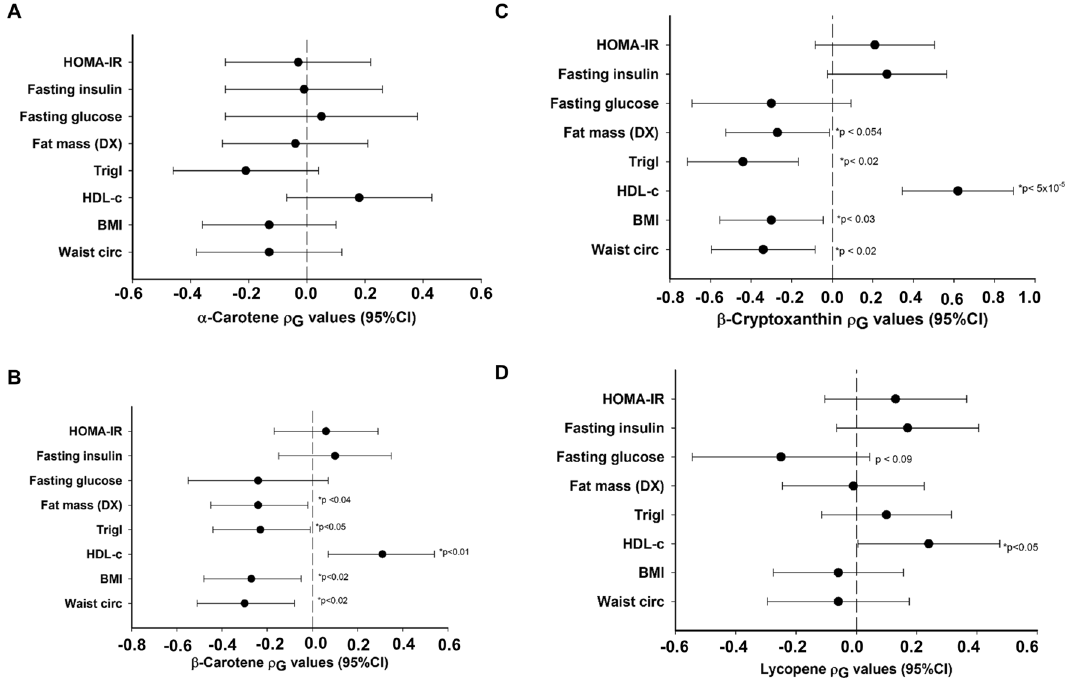
Figure 1. Genetic correlation coefficients (ρG) from α-carotene ( A ), β-carotene ( B ), β-cryptoxanthin ( C ), and lycopene ( D ) and their correlation with CMTs. The solid dots show the estimated rho coefficient; bars correspond to 95% confidence intervals, and the dotted vertical line corresponds to the absence of correlation (ρG = 0). Both carotenoids show a positive correlation with HDL-C. Several obesity-related traits showed a negative correlation with β-carotene and β-cryptoxanthin. If the FDR correction is applied, the significant P-value threshold is < 0.02 (corresponding to a nominal P-value < 0.05). For simplicity, the data for SBP and DBP are not shown.